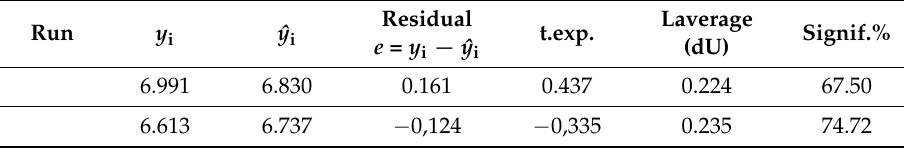
Table 7. Validation of the model with the check-points.